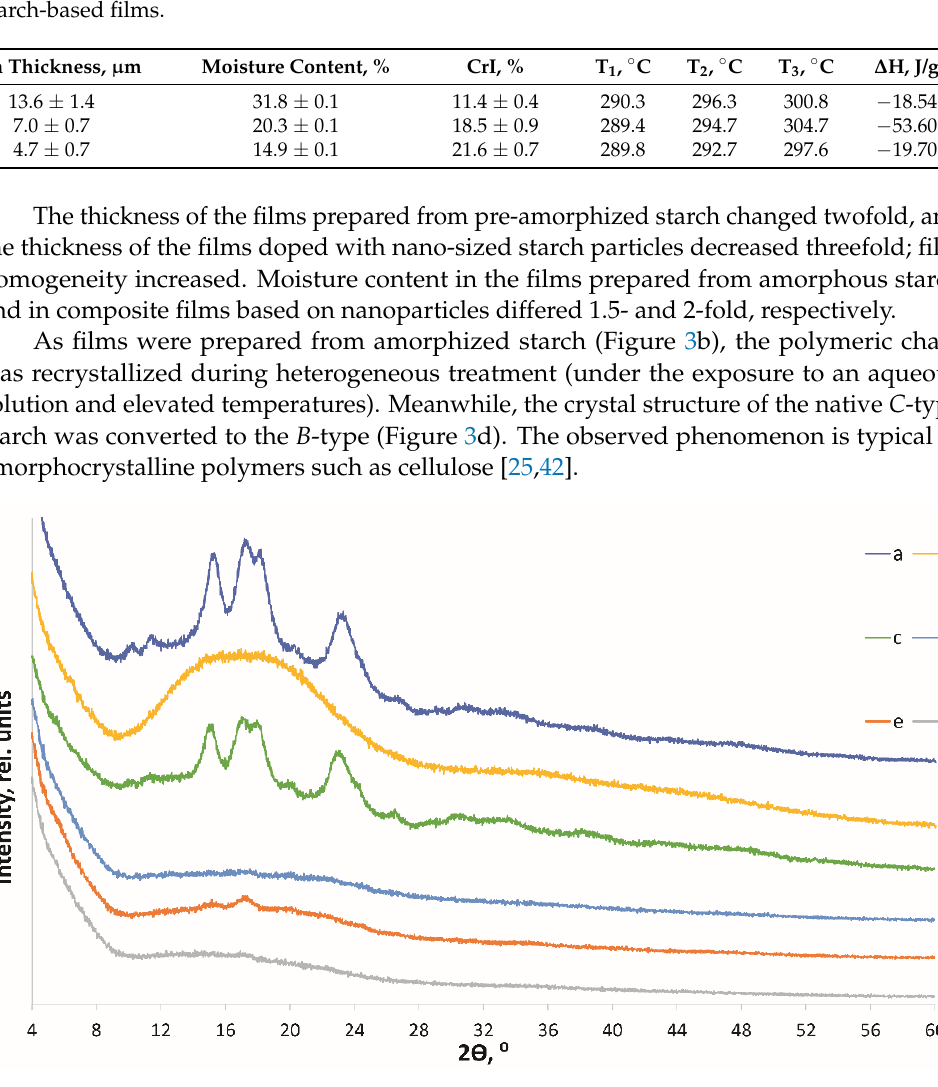
Table 2. Thickness, moisture, the crystallinity index, and thermal properties of native and nano starch-based films.